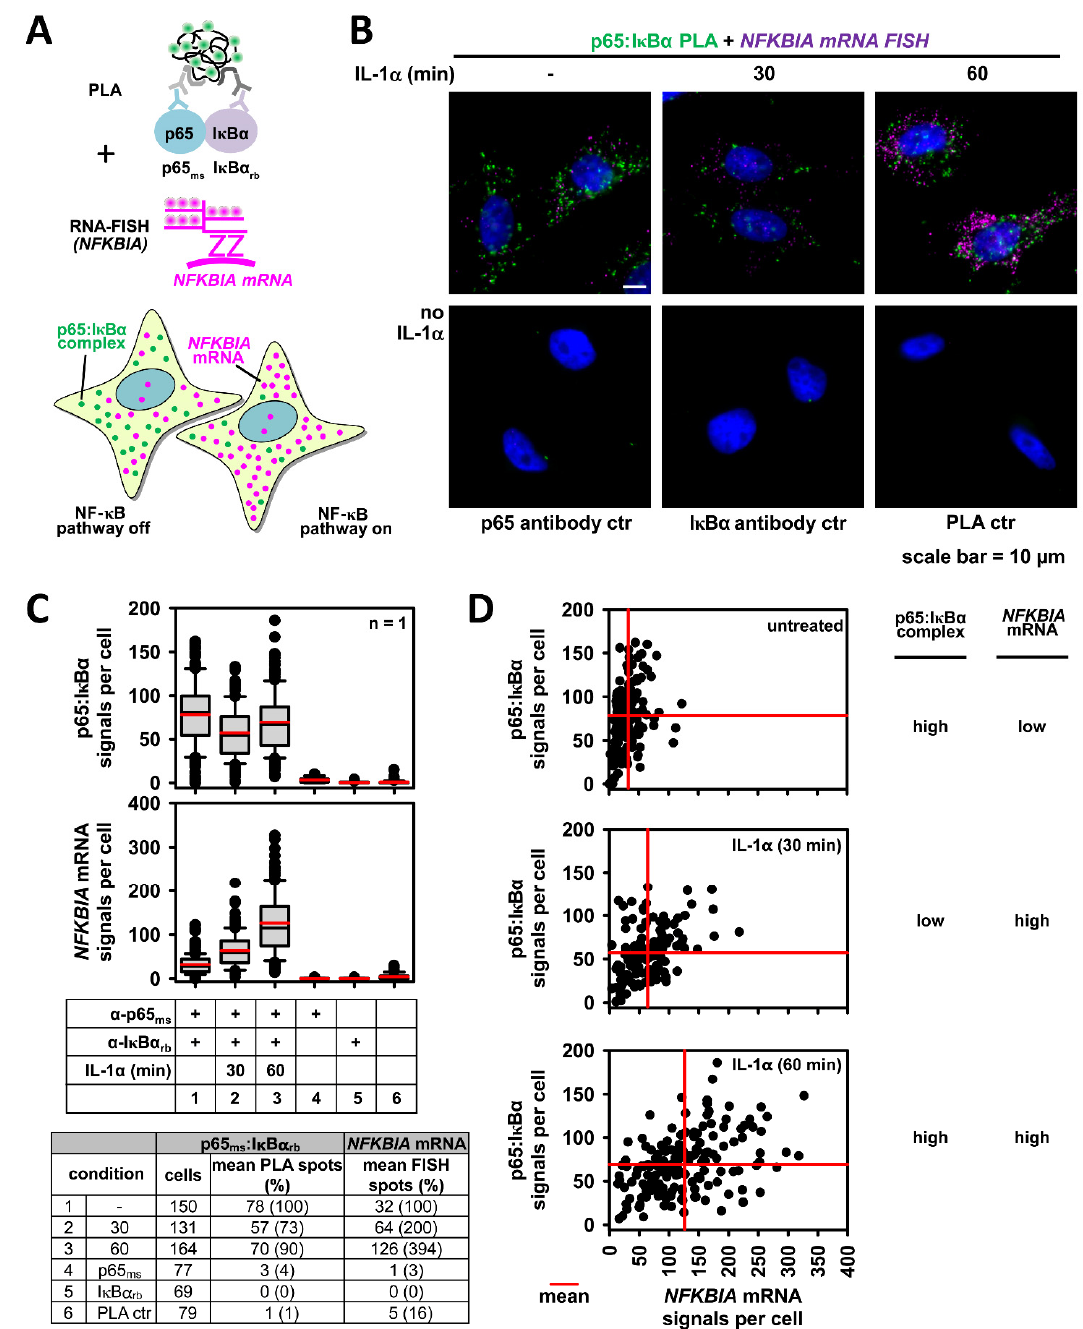
Figure 7. Advanced analysis of NF- κ B activation: Monitoring key steps of cytosolic and nuclear NF- κ B pathways in individual cells by combined PLA-RNA-FISH assays. ( A ) Scheme of the modified PLA procedure coupled to smRNA-FISH that allows to discriminate p65/I κ B α complex formation in unresponsive cells compared to (neighboring) cells showing the IL-1 α -induced dimished occurrence of p65/I κ B α complexes along with increased expression of NFKBIA mRNAs encoding the I κ B α protein. ( B ) HeLa cells remained untreated or were stimulated for 30 or 60 min with IL-1 α (10 ng/mL) as shown. Cells were fixed and p65/I κ B α complexes were revealed by PLA with specific antibodies followed by NFKBIA smRNA-FISH. PLA signals appear in green, NFKBIA FISH signals in pink and nuclei in blue (stained with Hoechst 33342). The cells were analyzed by fluorescence microscopy, representative merged pictures and PLA-negative controls (from untreated cells) are shown. ( C ) Both, PLA and smRNA-FISH signals were counted by the Duolink ® ImageTool. The box plots show the distribution of PLA or smRNA-FISH signals. The table summarizes all relevant single cell data. ( D ) For each cell the number of p65/I κ B α complexes was plotted against the NFKBIA smRNA-FISH signals. Data from untreated and IL-1-stimulated conditions are depicted as separate scatter plots, red lines indicate mean signals. The figure and legend were reproduced from Figure 6 of [121] under creative common